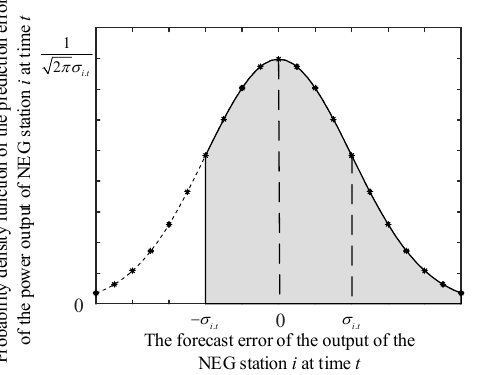
Figure 3. Probability density function diagram of output prediction error of the REG station.